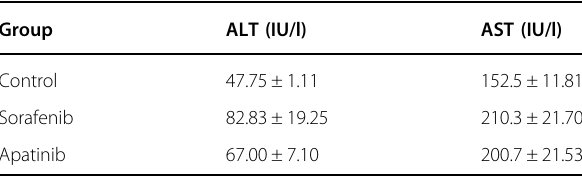
Table 2 Serum alanine transaminase (ALT) and aspartate transaminase (AST) levels in the control, sorafenib,